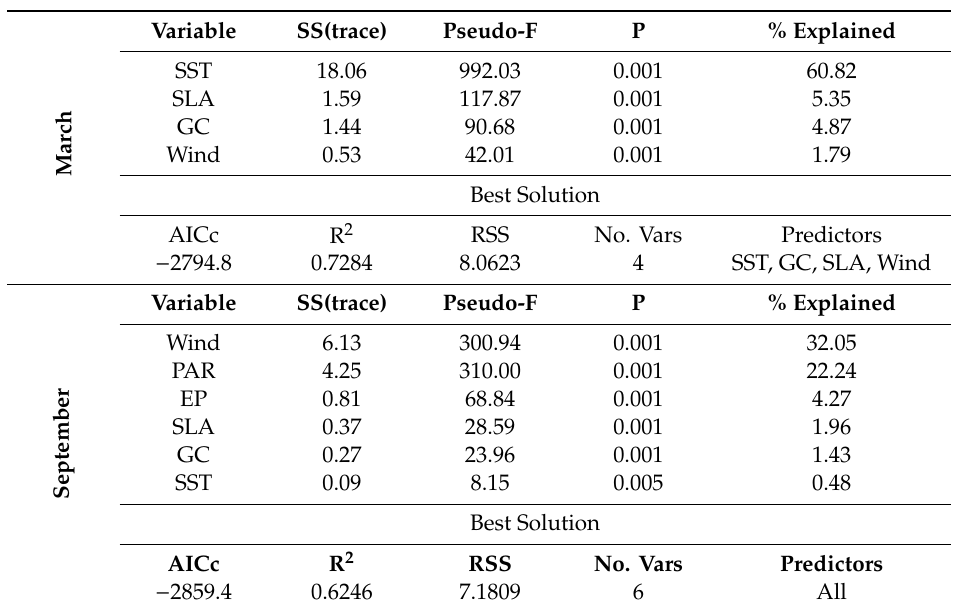
Table 1. Chlorophyll-a variance explained by the environmental variables in the PB for March and September. The marginal tests shows the relative contribution of each variable tested individually: SS denotes the total sum of squares of the complete multivariate data, the Pseudo-F value indicates the probability of a relationship between the Chl-a and the physical variable as a predictor, P is the p -value, and the % explained is the proportion of the variation explained by each variable. The conditional tests show the best combination of the environmental predictor variables that explain the largest amount of the variation in the response variable (Chl-a) based on the smallest value of Akaike’s information criterion (AIC). R 2 is the proportion of the explained variation for the model, RSS is the SS residual and No. Vars refers to the number of predictor variables used by the best solution